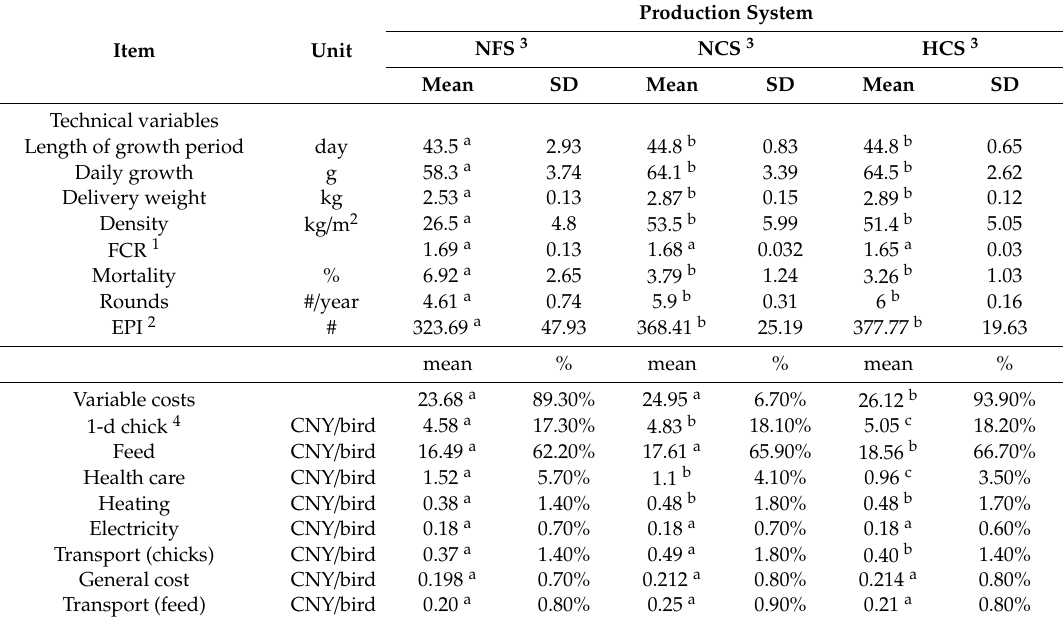
Table 1. Technical inputs, costs, and profits per delivered